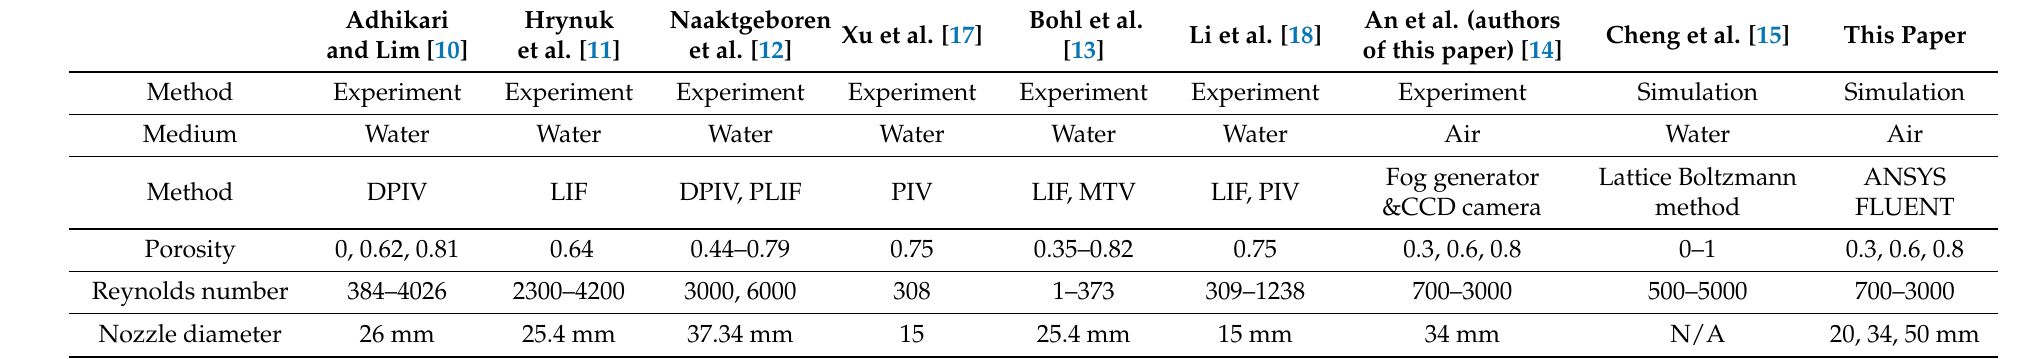
Table 1. Comparing the current study with previous studies on the interaction of vortex rings and porous